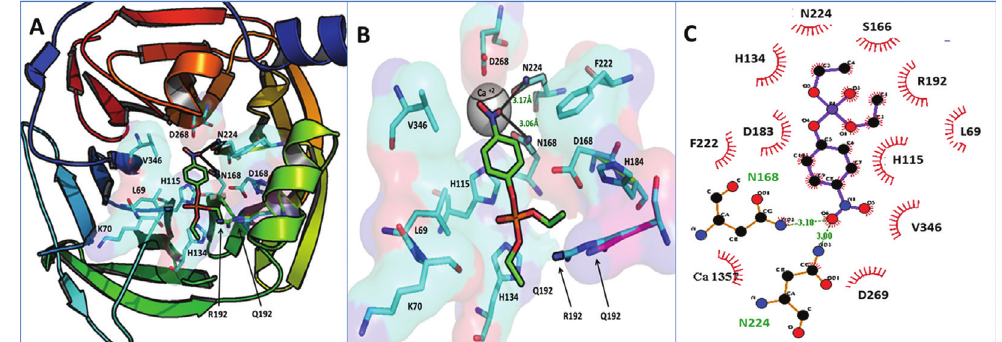
Figure 2 - Docked conformations of paraoxon in PON1 binding pocket. (A) Paraoxon bound in PON1 binding pocket. (B) Zoomed in binding pocket of PON1, paraoxon terminally making two hydrogen bonds with N168 and N224. Notice that R192 adopts a conformation more proximal to the binding pocketopeningthanthatofQ192,steeringtheligandtoadoptthemostsuitableconformationforparaoxonaseactivitybyH115andH134dyad.(C)2Dil- lustrationofparaoxonbindinginPON1bindingpocket;paraoxonformstwohydrogenbondswithAsn224(3.00Å)andAsn168(3.18Å)showningreen while a number of hydrophobic interactions with the residues configure the binding pocket